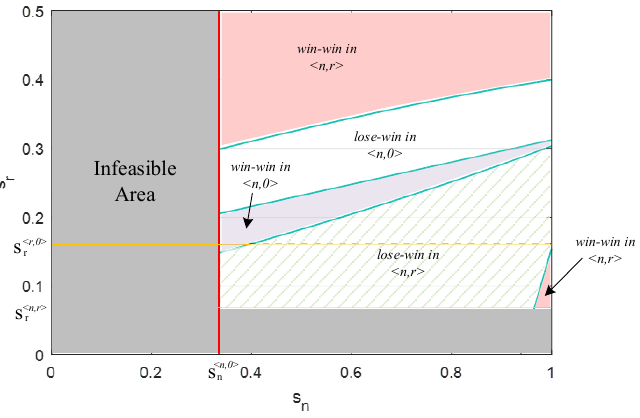
Figure 7. “Lose/win” in < n , 0 > and < n , r > scenarios.